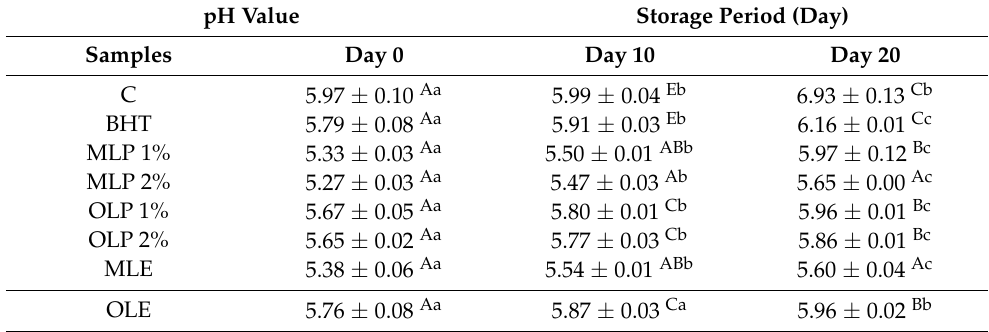
Table 5. The pH values of different chicken burger samples during storage for 20 days, at 4 ◦ C.